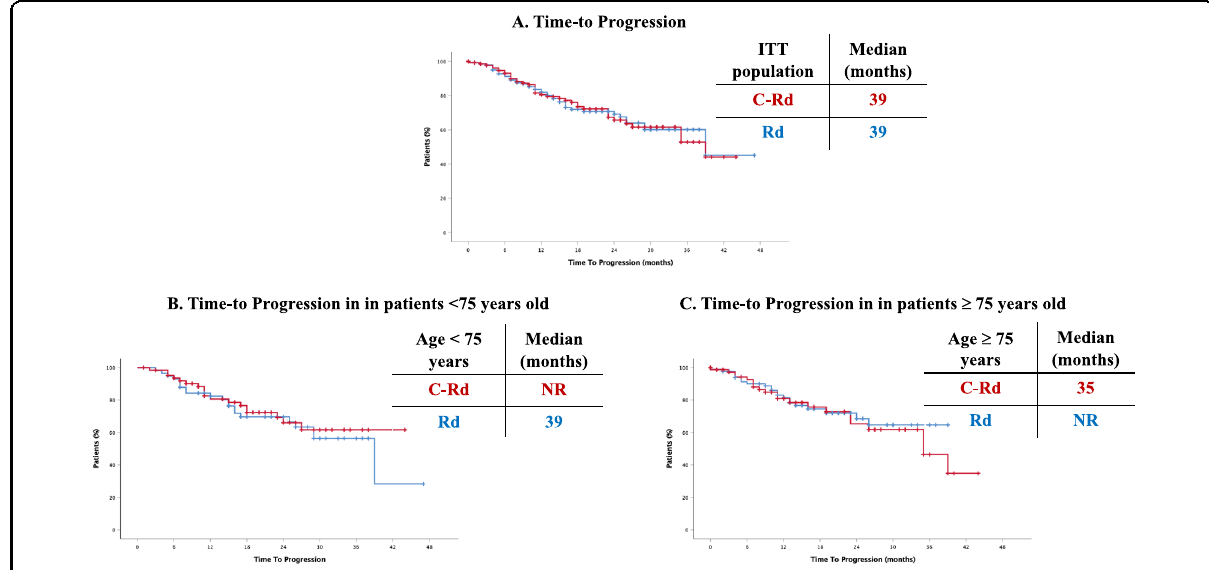
Fig. 2 Time-to progression. A In the overall cohort, ( B ) In patients <75 years old, ( C ) In patients ≥ 75 years old.